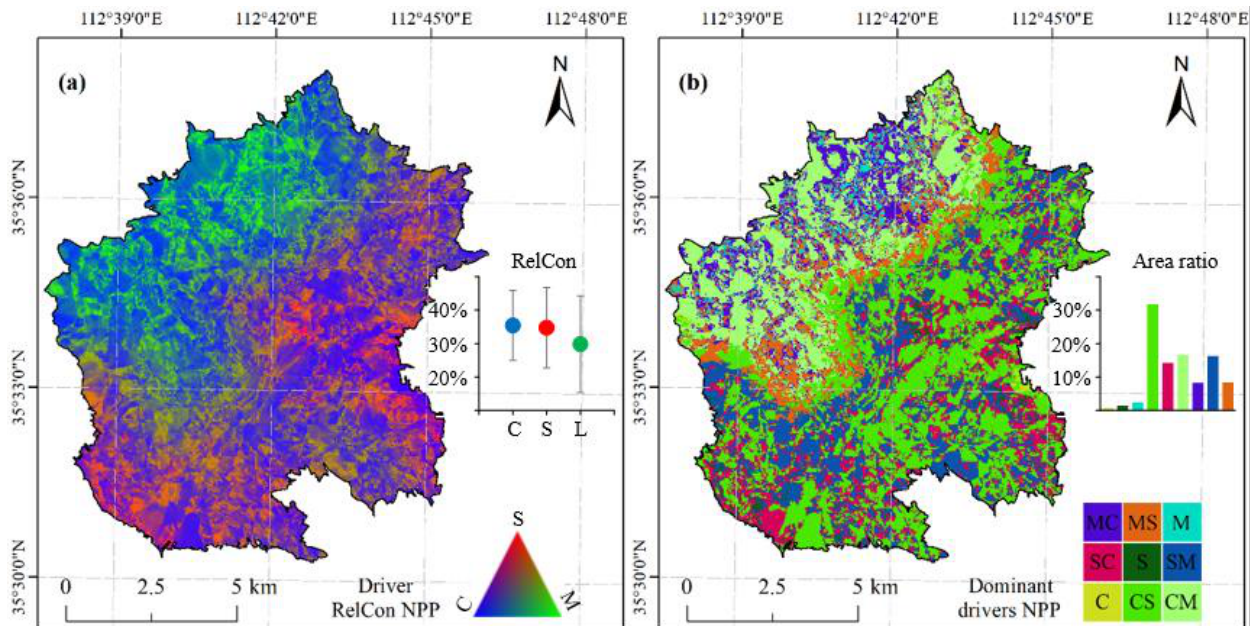
Figure 5. Relative contribution of different categories of driving factors to the spatial variation of NPP in the Changhe Basin mining area. ( a ) Spatial distribution map of the relative contributions of climate (C), soil properties (S), and mining activities (M) to NPP variability. ( a ) The right inset represents the average relative contribution of different categories of drivers, and whiskers represent the standard deviation of all pixel values. The right inset of ( b ) represents the proportion of control area that dominates the driver. C, S, and M in ( b ) represent climate, soil properties, and coal mining activities, respectively. The combination of C, S, and M indicates that the coupled effects of different categories of drivers dominate the spatial variation of NPP. For instance, CS (SC) represents the coupled effects of climate and soil properties, with a larger relative contribution from the former drivers. CM (MC): the combined effects of climate and mining activities, SM (MS): the combined effects of soil properties and mining activities.